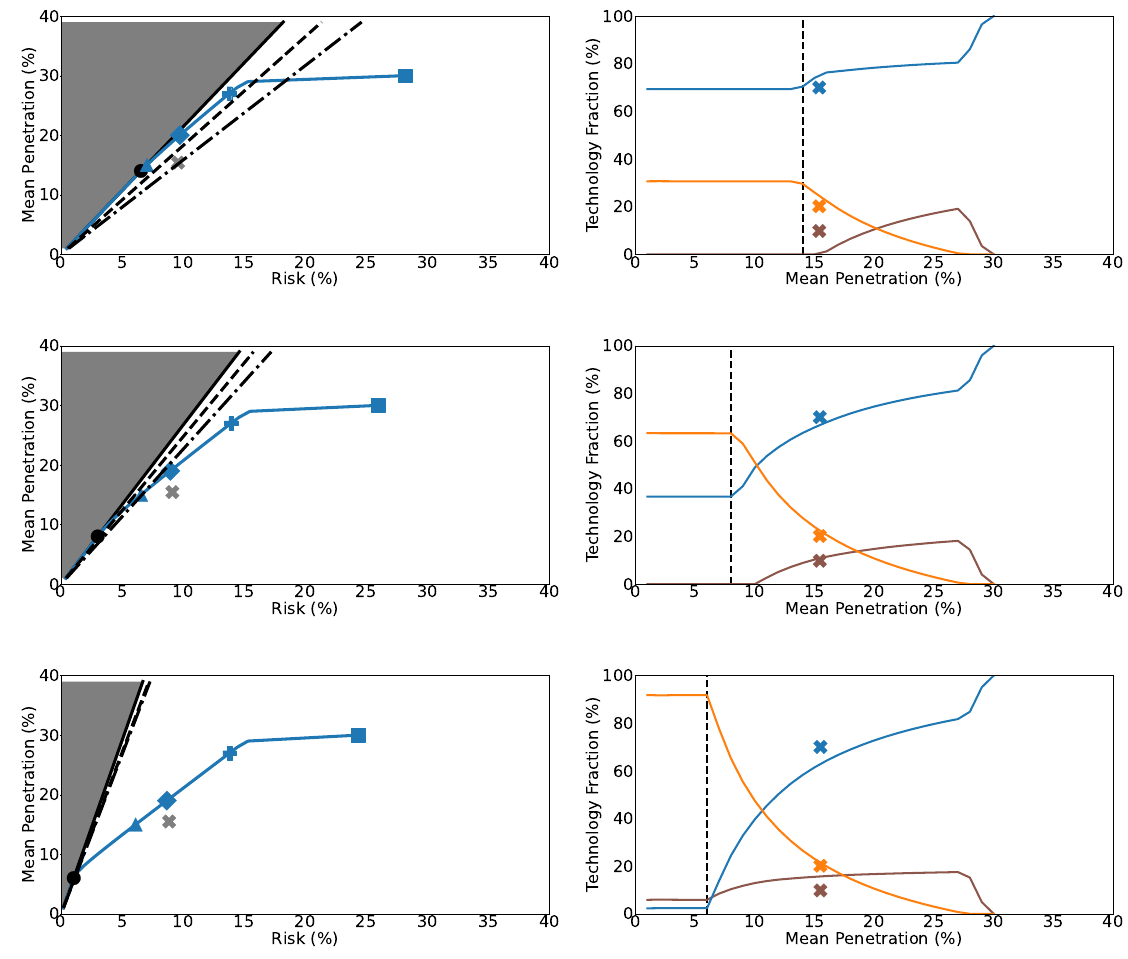
Figure 5. Left : approximations of the fronts with the risk, σ global/technology/base , in abscissa and the mean penetration (1), µ , in ordinate. Right : shares of wind (blue line), PV (brown line) and CSP (orange line) capacities versus the mean penetration for the global strategy with maximum-cost constraint. Top : PV-Wind-CSP-SM2. Middle : PV-Wind-CSP-SM3. Bottom : PV-Wind-CSP-SM4. In each panel, different fronts are represented. Each point of the front represented by the plain blue curve is associated with a Pareto-optimal mix, taking into account correlations between technologies and zones (global strategy) while satisfying the maximum-cost constraint (3). The straight black line passing through the origin represents the front for the global strategy as well, but without the maximum-cost constraint. Points to the right of this front are not Pareto optimal. Points to the left of this front (in gray) are not